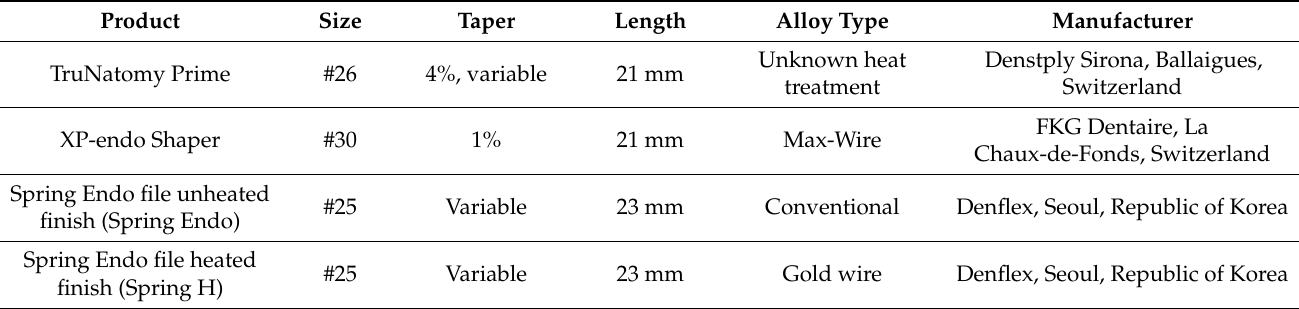
Table 1. Specifications of NiTi rotary instruments used in this